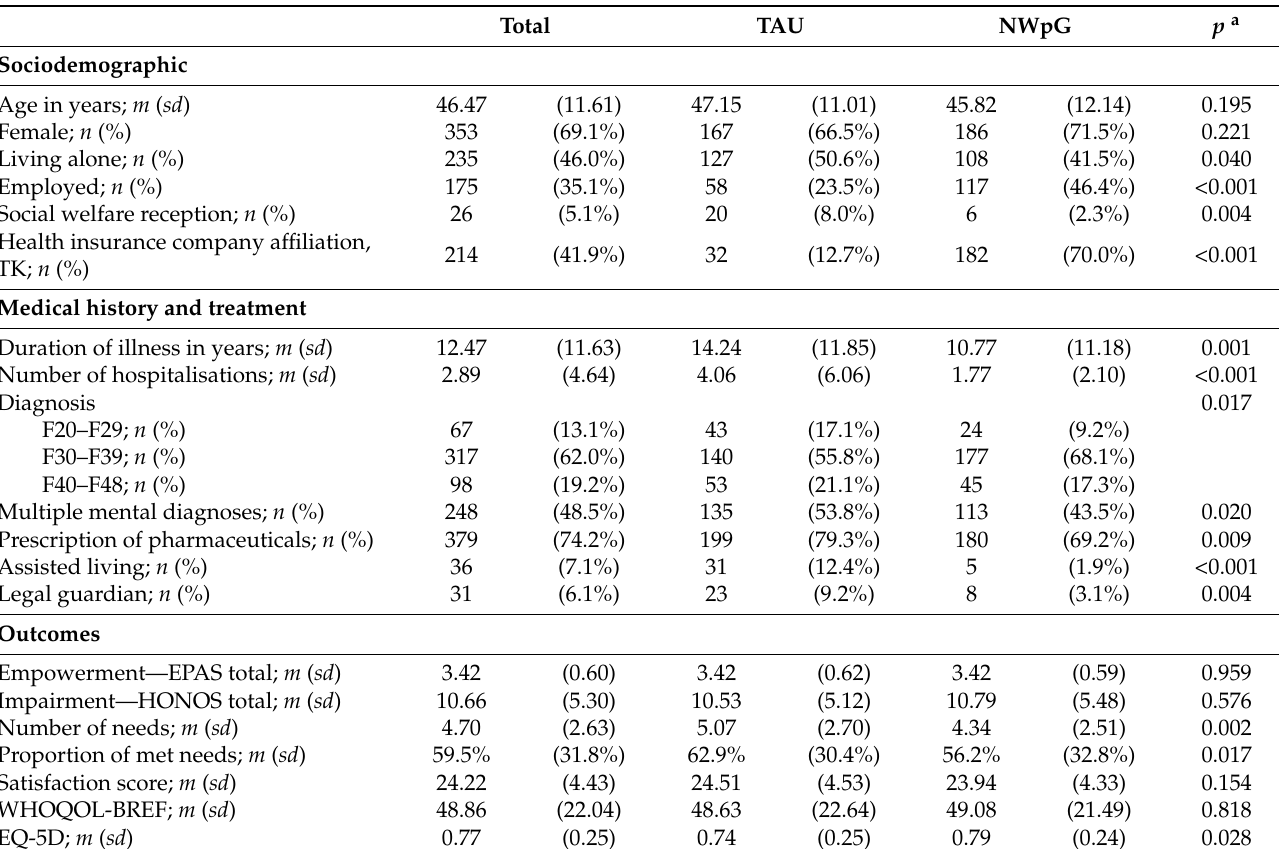
Table 1. Sample characteristics at